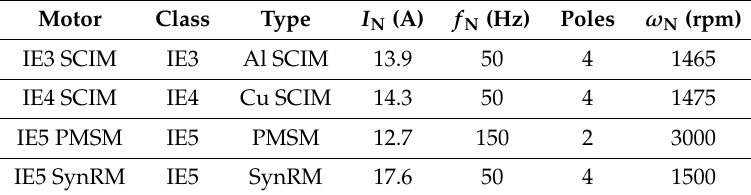
Table 1. Main characteristics of the tested 7.5-kW, 400-V, 50-Hz motors.